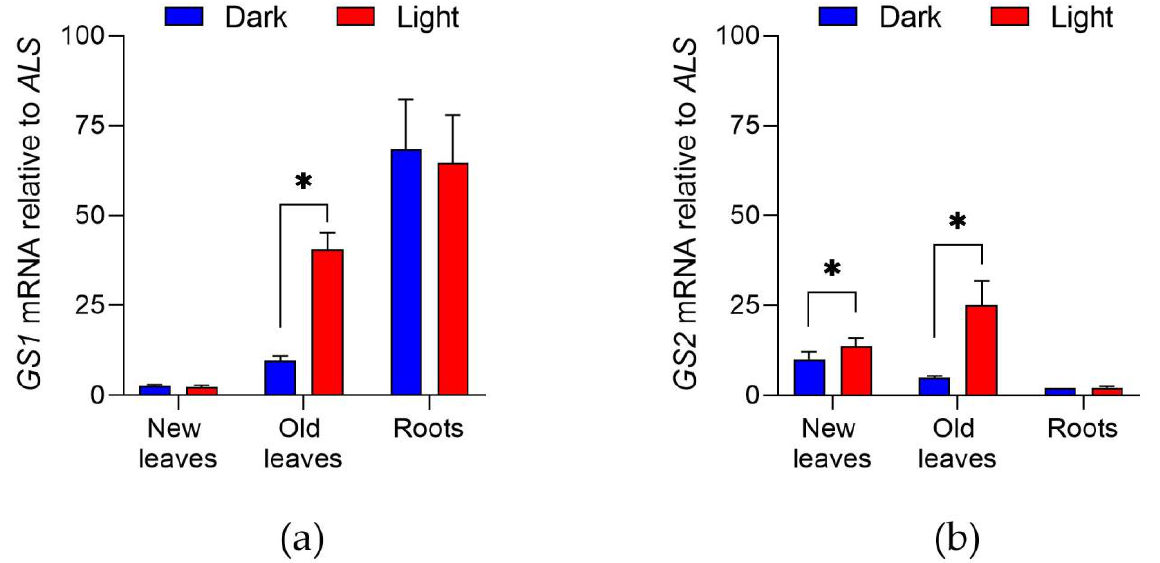
Figure 2. Glutamine synthetase (GS) genes are differentially expressed in the light compared to the dark depending on the plant tissue. GS1 ( a ) and GS2 ( b ) mRNA expression relative to ALS in new leaves, old leaves, and roots of A. palmeri plants growing in the light and in the dark. Asterisks indicate significant differences by t-test ( p < 0.05) between light versus dark within each plant part.